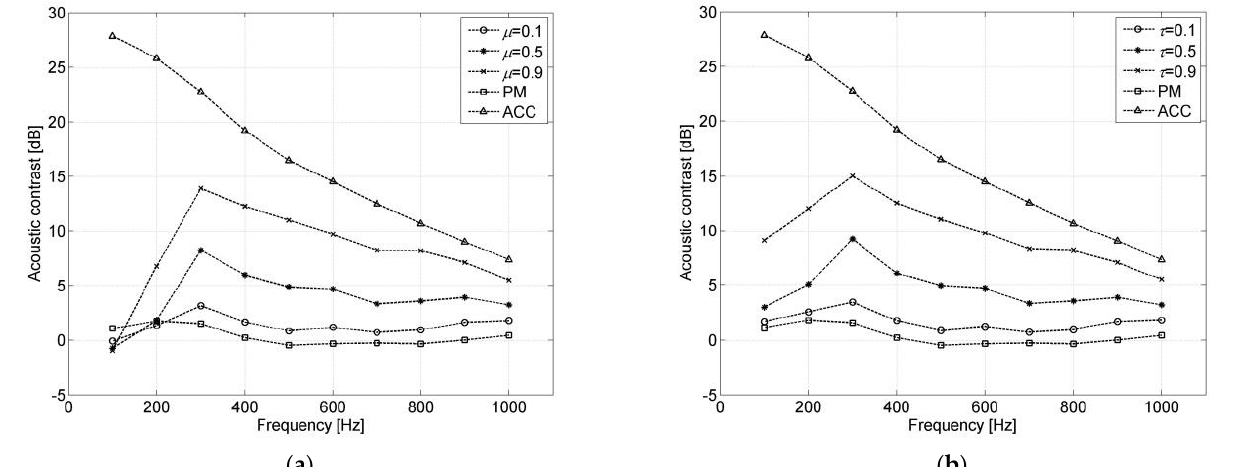
Figure 4. Acoustic contrast of different methods for two-dimensional experiment. ( a ): PM method in bright zone, ACC method, the first proposed method with µ = 0.1, 0.5 and 0.9; ( b ): PM method in bright zone, ACC method, the second proposed method with τ = 0.1, 0.5 and